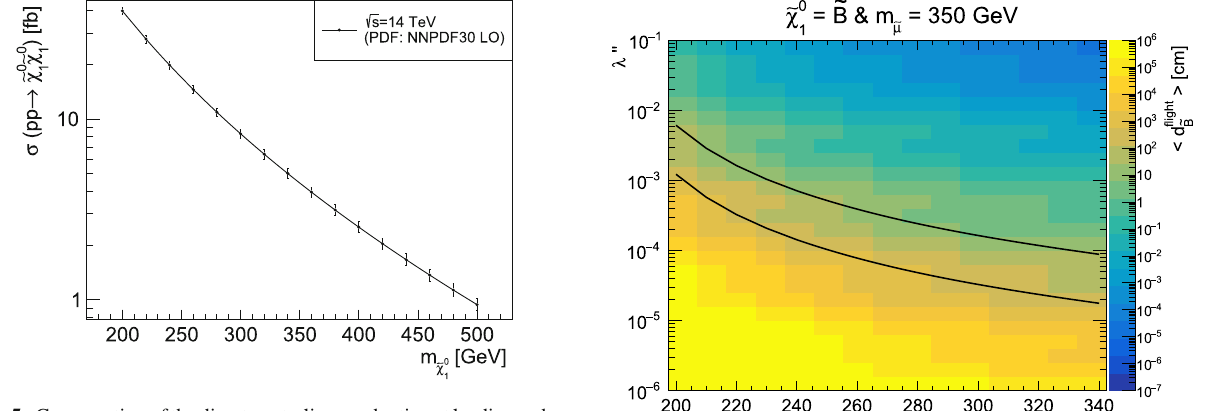
. The uncertainties are related 1 (cid:4) of the neutralino ˜ B -like in the Fig. 7 Average flight distance (cid:3) d flight ˜ B laboratory frame as a function of λ (cid:5)(cid:5) and the neutralino mass m ˜ χ 0 . We 1 assume a smuon mass of m ˜ μ = 350 GeV. The black lines represent the geometrical limits of the tracker volume